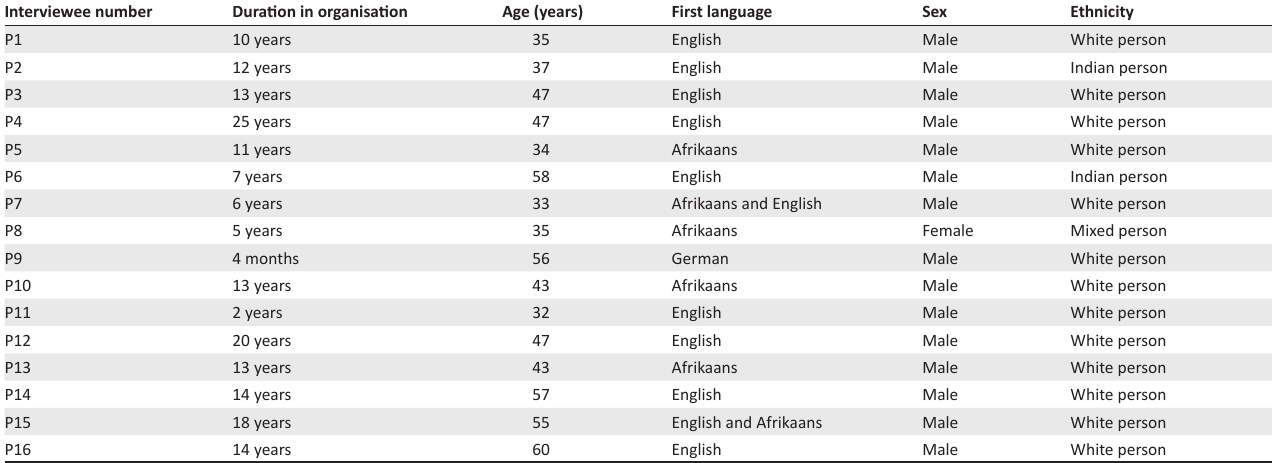
TABLE 1: Demographical